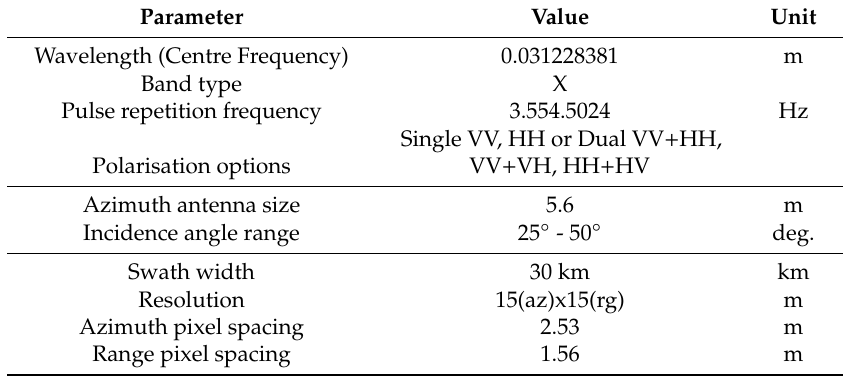
Table 2. COSMO-SkyMed stripmap (ping-pong) mode acquisition platform parameters.